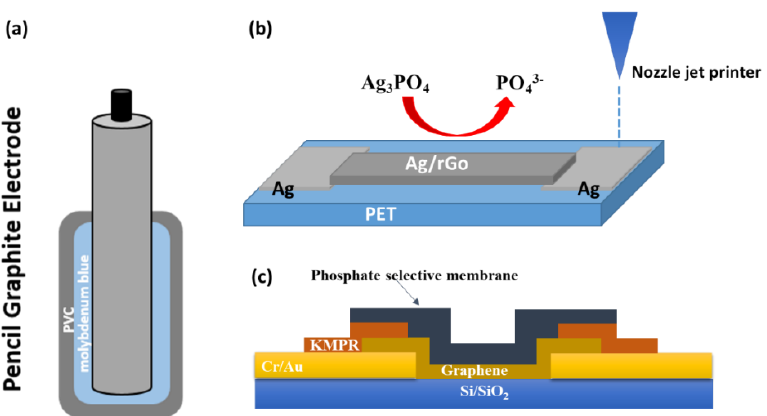
Figure 7. Redrawing of ( a ) Pencil graphite sensor coated with Molybdenum blue functionalized poly(vinyl chloride) following [212], ( b ) Nozzle-Jet-Printed Silver/Graphene Composite/Field-Effect Transistor Sensor following [212] and ( c ) ISFET structure with the phosphate selective membrane following [219].